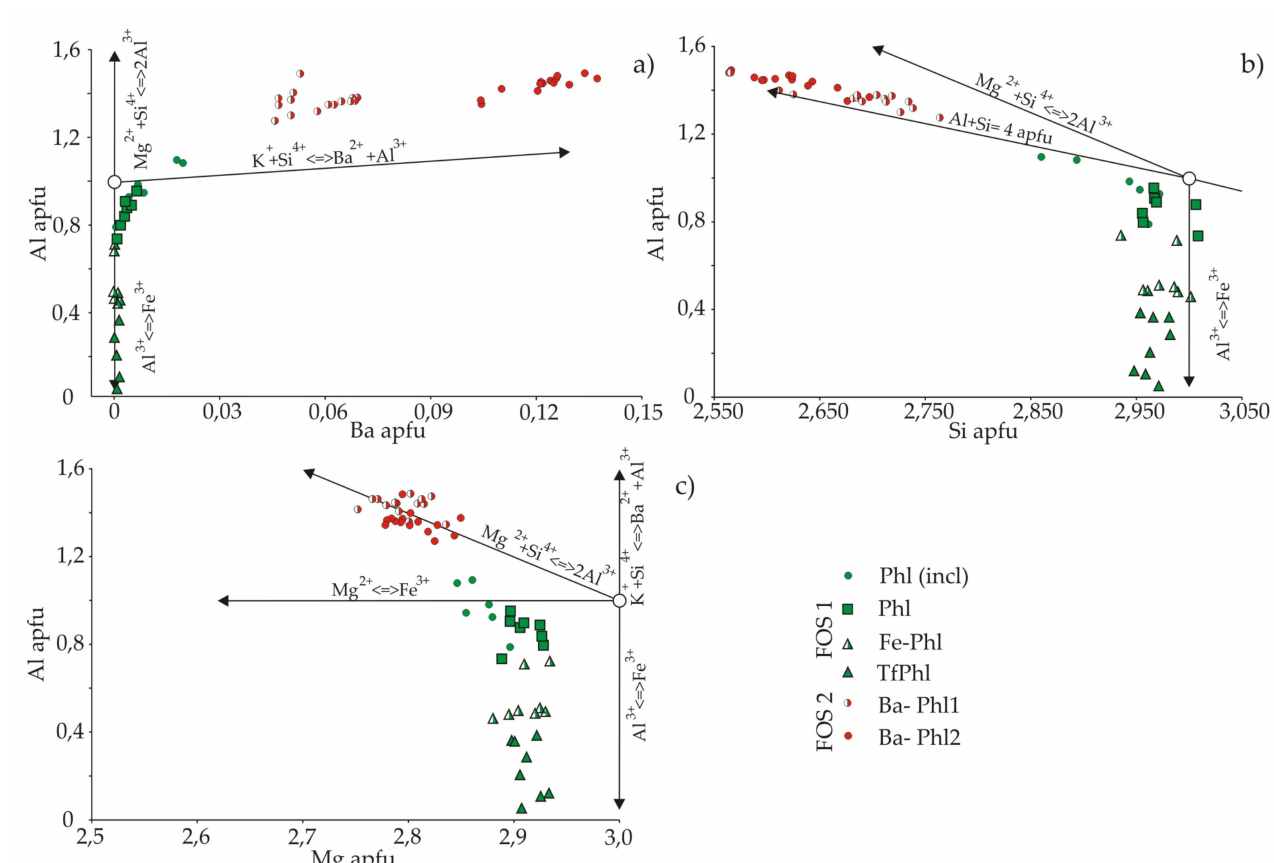
Figure 7. Variations in phlogopite compositions from Arbrastach phoscorites ( a ) Ba; ( b ) Si; ( c ) Mg versus Al. Zirconolite is present only in FOS 1, and its chemical composition differs from the empirical formula, CaZrTi 2 O 7 . Although naturally occurring zirconolites may be rich in Nb and Ta [36], the analyses in Table 4 are specifically adjusted for the laachite formula to show the similarity of the chemical composition of the zirconolites to this mineral described by Chukanov and others [37]. The concentration of Nb + Ta is high (1.28 to 1.48 apfu.) and in some cases can equal Ti (1.50 to 1.75 apfu.). The zirconolite also contains REE, mainly Ce and Nd (total REE 0.30–0.58 apfu.). It is difficult to give an exact name to this mineral since Fe is absent in the zirconolite formula presented in The New IMA List of Minerals (January 2021). However, in many crystallographic studies of Nb-rich zirconolites [38,39], a separate position M5 for Fe is distinguished in the “doubled” formula of zirconolite (the center is a pentagonal polyhedron that separates the edges with an